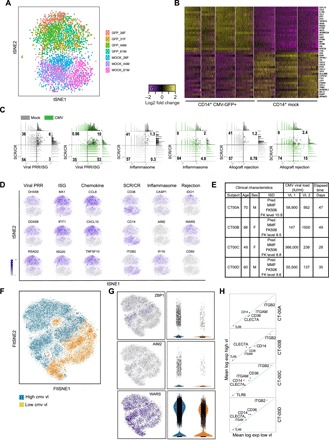
scRNA-Seq demonstrates that CMV-infected monocytes uniformly express viral PRRs, IFN-induced cytokines, and pro-inflammatory chemokines but maintain a heterogenous pattern of expression of scavenger receptors, complement receptor 3, inflammasome activation, and non-chemokine biomarkers of allograft rejection.(A) Single mock CD14+ and CMV-infected CD14+GFP+ monocytes cluster in distinct populations by tSNE. (B) Heat map with hierarchical clustering demonstrating the top 20 up-regulated and down-regulated transcripts in CMV-infected monocytes compared to mock. (C) SeqGeq dot plot demonstrating the combined expression of families of transcripts, including scavenger receptor/complement receptor (Σ CD36, CD14, STAB1, and ITGB2), viral PRRs (Σ MX1, MX2, DDX58, and DHX58), inflammasome (Σ CASP1, CASP4, AIM2, and IF16), and allograft rejection (Σ IDO1, WARS, TAP1, and CD80) in single cells from mock- and CMV-infected monocytes. (D) tSNE plots comparing expression of DDX58, DHX58, RSAD2, MX1, IFIT1, ISG20, CCL8, CXCL10, and TNFSF10 to expression of CD36, CD14, ITGB2, CASP1, AIM2, IFI16, IDO1, WARS, and CD80 in CMV-infected monocytes. Single-cell expression is represented on gray-purple scale. (E) Clinical characteristics of four cardiac transplant recipients with detectable peripheral CMV viremia. (F) CD14+ monocytes obtained from heart transplant recipients during periods of high and low CMV viremia cluster in distinct populations by FItSNE. (G) Violin plots demonstrating expression of viral PRR ZBP1, inflammasome gene AIM2, and allograft rejection–associated genes WARS in all four transplant recipients and (H) scatter plots showing changes in expression of PRRs CD36, CD14, ITGAM/ITGB2, CLEC7A, and TLR6 from individual heart transplant recipients. Genes with significant expression changes by Welch’s t test, Fisher’s exact test, and Mann-Whitney U test with Benjamini-Hochberg procedure applied are shown in capital letters; genes depicted in lowercase italics did not meet criteria for significant change in expression. PRR, pathogen recognition receptor. SCR, scavenger receptor; VL, viral load.